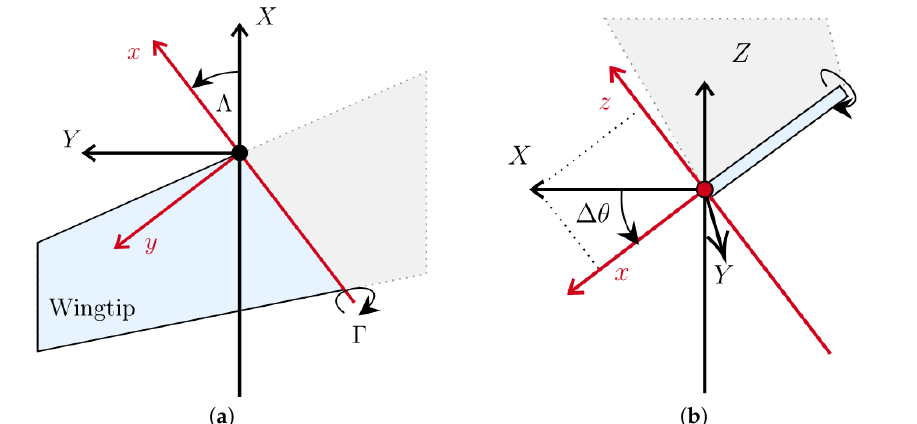
Figure A1. Axis, reference frames and angles linked to wingtip change in pitch with fold: ( a ) top view—normal to (X,Y) plane; and ( b ) side view—normal to (x,z)